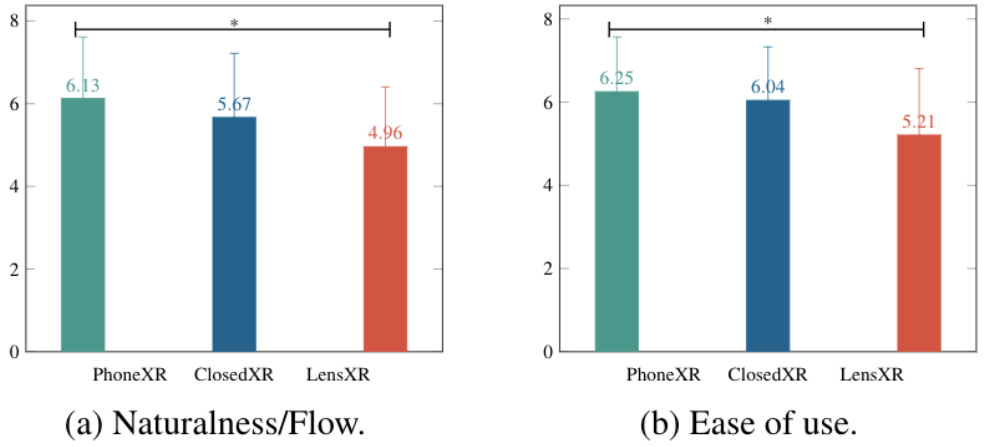
Figure 5. Survey results regarding the mode switch experience—statistical differences are indicated with the “*” mark and illustrated by color grouping. The vertical axes represent the subjective levels in the 7-point Likert